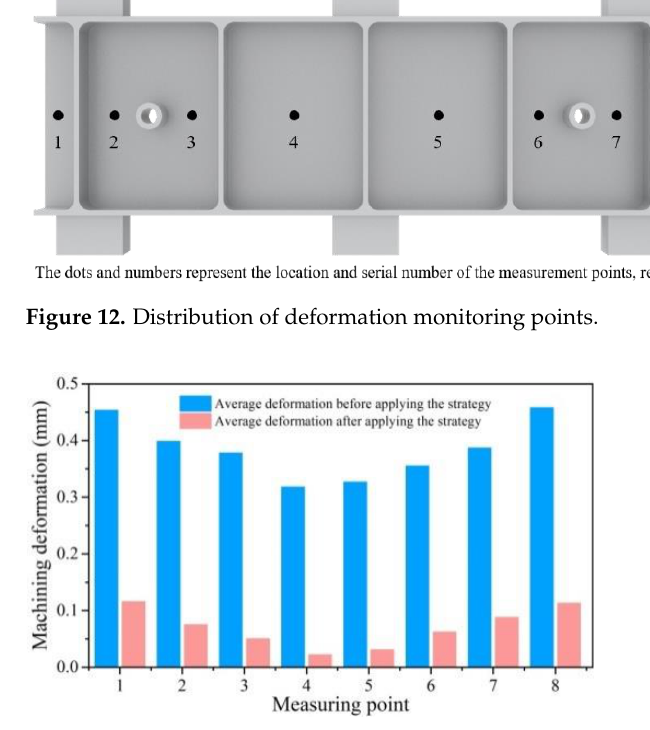
Figure 13. Comparison of the deformation before and after applying clamping control strategy.